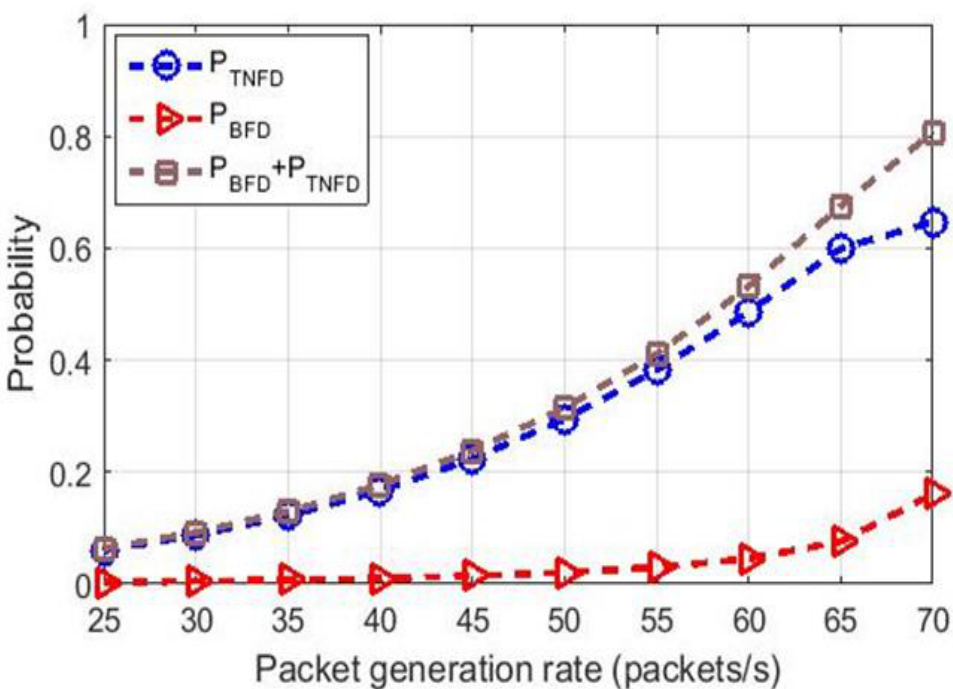
Figure 8. Probability for TNFD and FD communications vs. PGR.